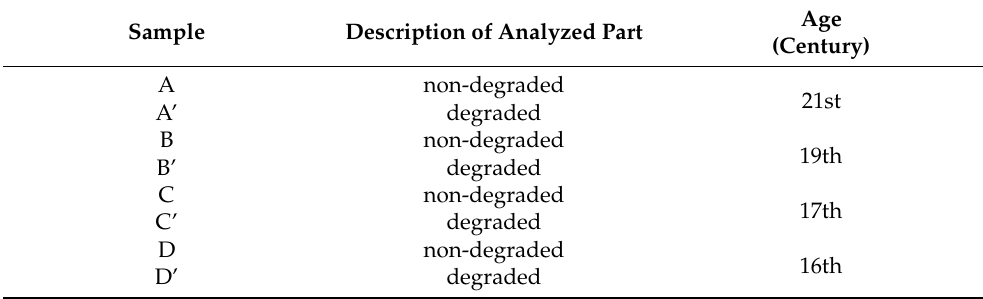
Table 1. Non-degraded samples (A, B, C, D) and degraded samples (A’, B’, C’, D’), and their relative age